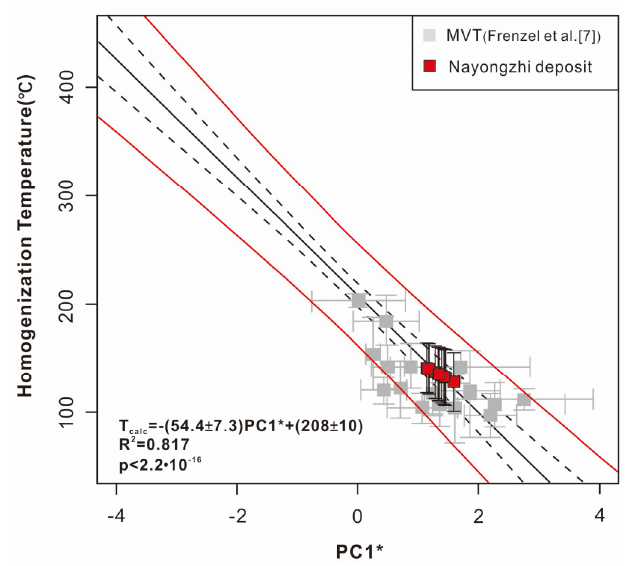
Figure 11. The homogenization temperature of the Nayongzhi deposit showing the GGIMFis geothermometer (modified after Frenzel et al. [7]). Note: the prediction intervals of linear fit are shown as the red lines. 95% confidence intervals are shown as the black dotted lines, while the line of best fit is shown as the black line.